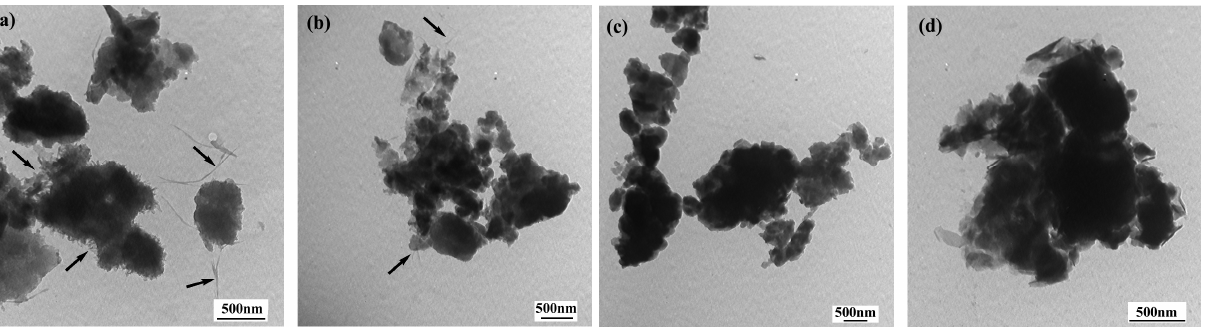
Figure 5. TEM images of the PANI/SWNTs composites with SWNTs: ( a ) 8 wt%; ( b ) 16 wt%; ( c ) 24 wt%; ( d ) 32 wt%.